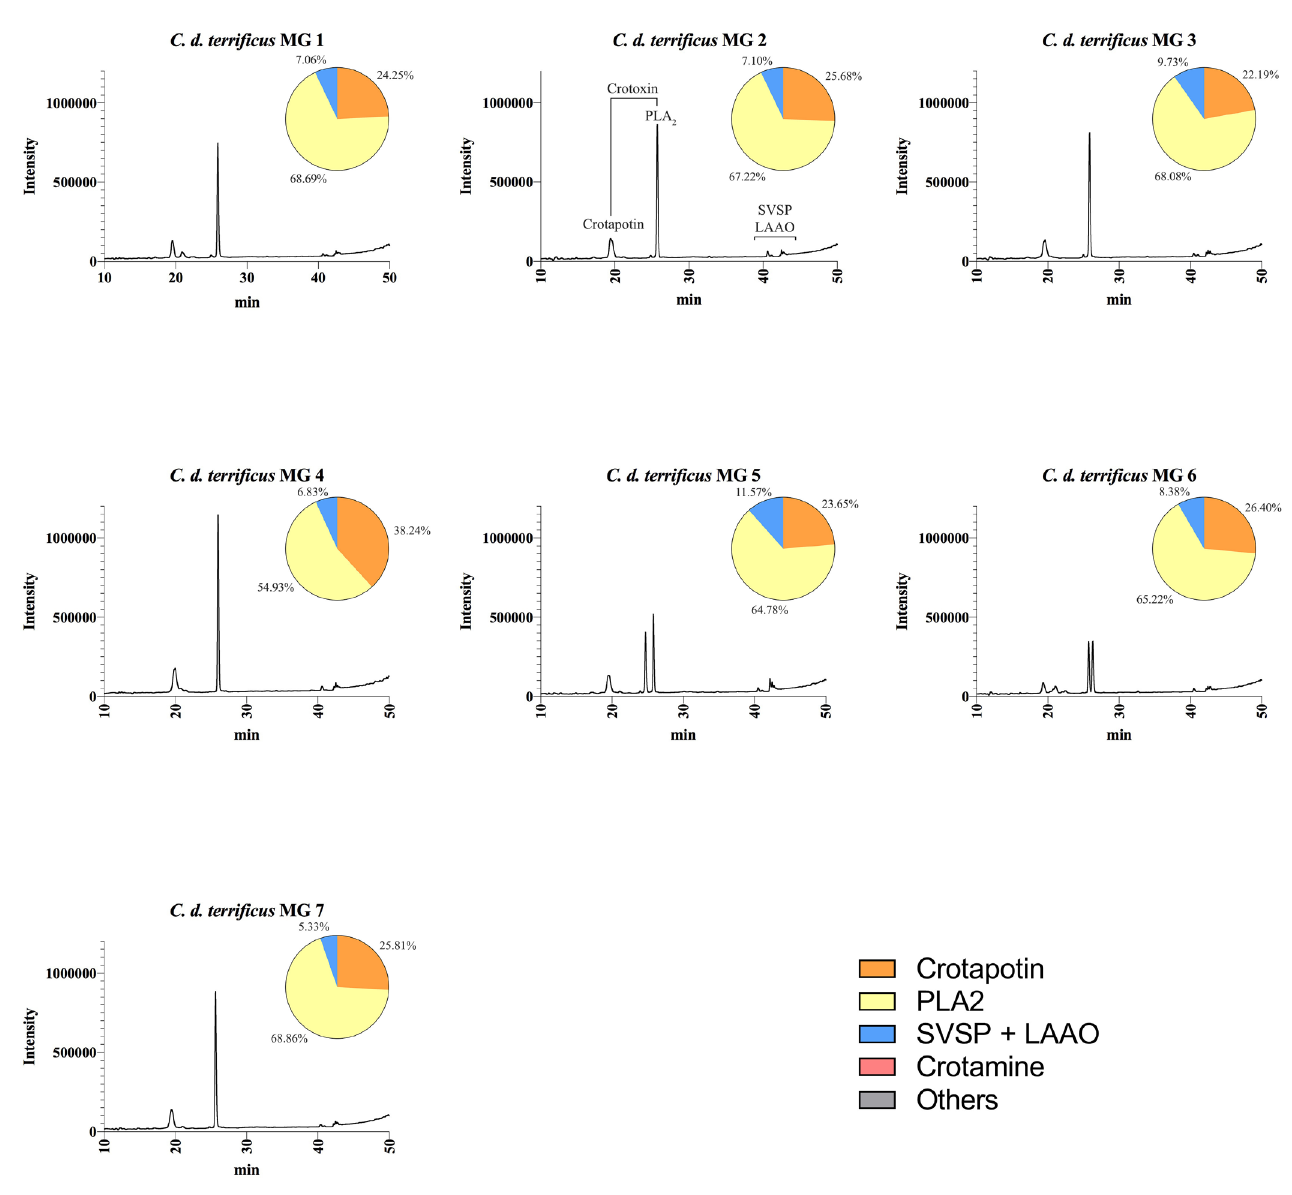
Figure 6. Elution profiles of individual C. d. terrificus venom from Minas Gerais state by RP-HPLC. Samples of 25 μg of lyophilized venom were dissolved in 0.1% trifluoroacetic acid (TFA) and 5% acetonitrile (solution A) and subjected to RP-HPLC on a C18 column. Elution was performed at 1.0 mL/min by applying a gradient toward 0.1% TFA and 95% acetonitrile (solution B), as described in the experimental section. The main chromatographic peaks of one representative were assigned to its major components. This representative was selected based on the presence/absence and intensity of particular chromatographic peaks. LAAO: L-amino acid oxidases; SVSP: snake venom serine proteases, PLA : phospholipases A . 2 2 [36,37], although C-type lectins and metalloproteinases, even in low amounts as those reported in the venom of this species [4,21,37], may also be